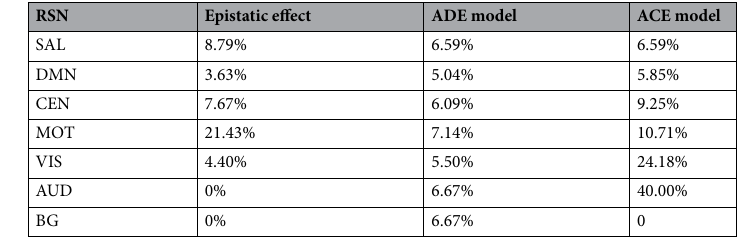
Post-hoc RSN-level analysis. The results of the post-hoc analyses concerning the main RSNs are summa- rized in Table 5. For each RSN, the group average values of FC are reported in Figure S3. All the ROIs included in each RSN are reported as nodes in the figure, together with the strongest functional connections (with values above the 0.5 threshold). For each RSN, the percentages of network connections associated with epistatic effects or with genetic and environmental factors expressed by ACE/ADE twin models are reported. On average, ACE model explained the highest proportion of links in the auditory (40%), visual (~ 24%), and central executive (~ 9%) networks. Epistatic effects were prevailing in the connections of the motor (~ 11%) and salience (~ 9%)